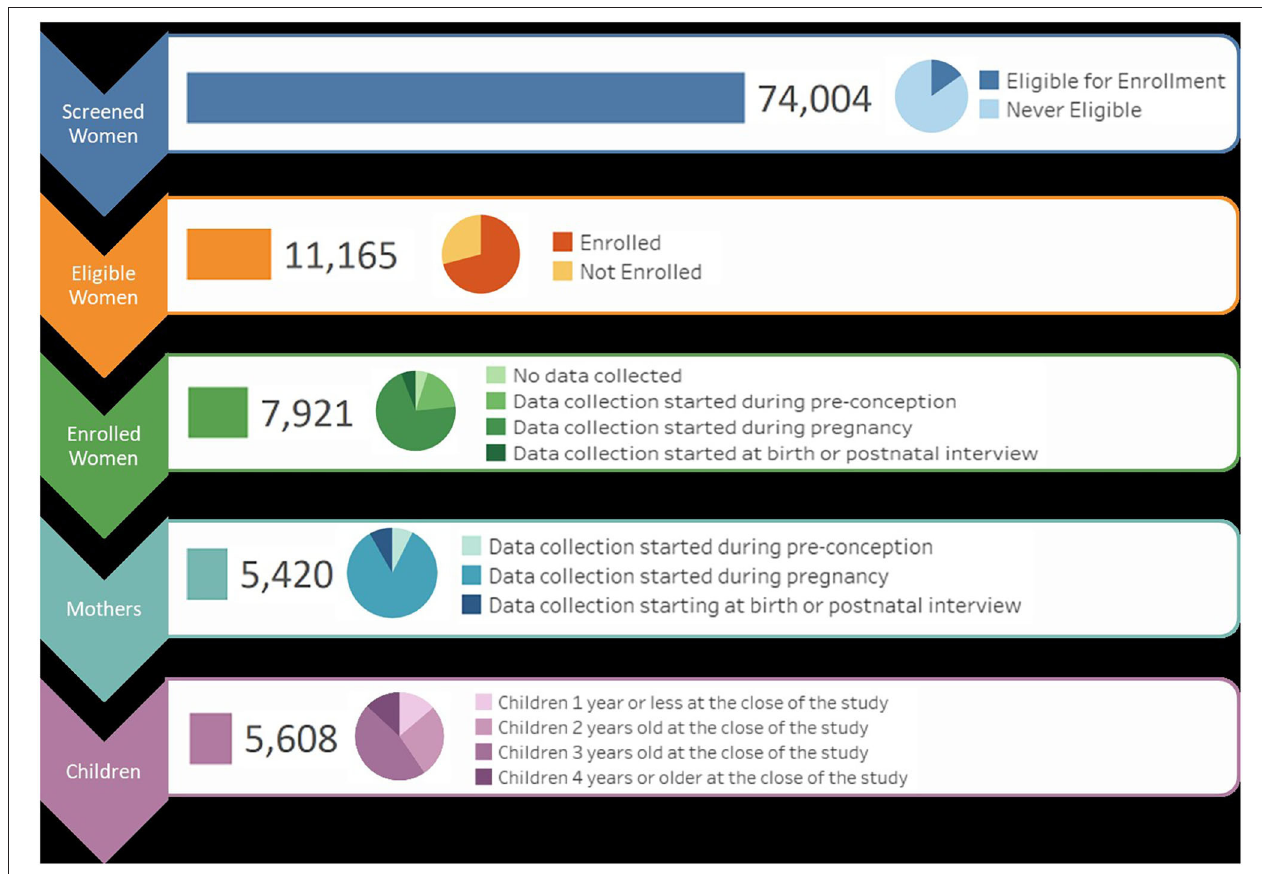
FIGURE 1 | NCS recruitment, enrollment, and study status flow by participant and